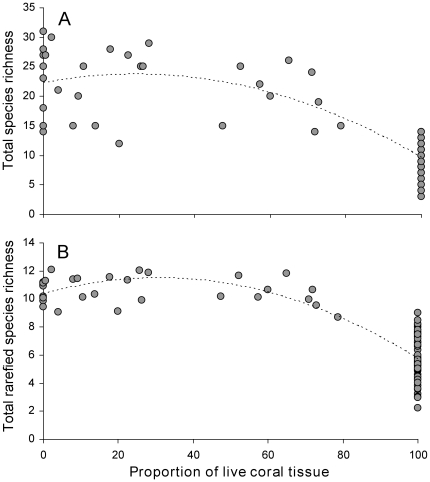
Effect of the loss of live coral tissue on overall decapod species richness.(A) Total decapod species richness: polynomial regression, y = −0.0025x
2+0.1214x+22.258; R2 = 0.72, N = 82, p<0.001. (B) Rarefied total decapod species richness: polynomial regression, y = −0.0012x
2+0.0746x+10.352; R2 = 0.67, N = 82, p<0.001.